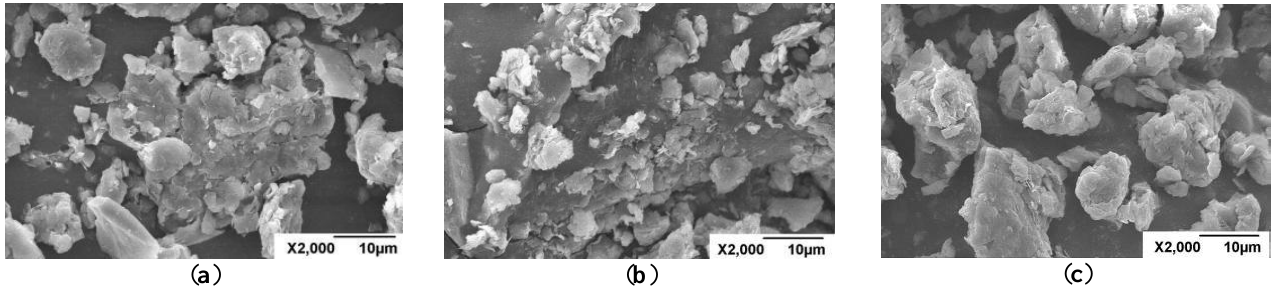
Figure 6. SEM images of bentonite subjected to different treatments. ( a ) Unhydrated, ( b ) Hydrated, ( c ) 0.1% AAS-8.